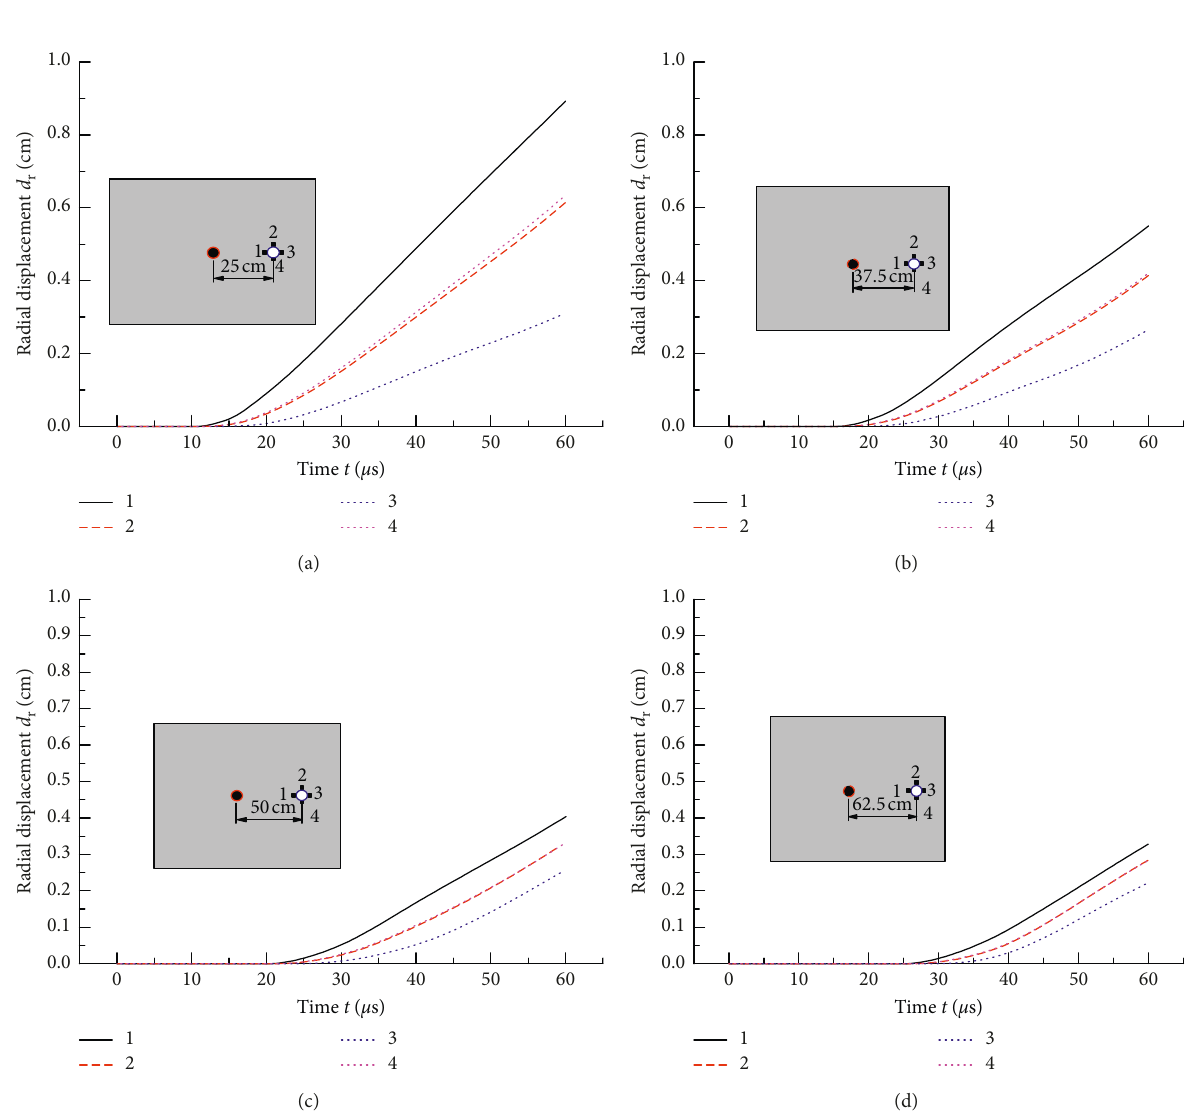
� 5, (b) a /2 r � 7.5, (c) a /2 r � 10, and 1 1 1